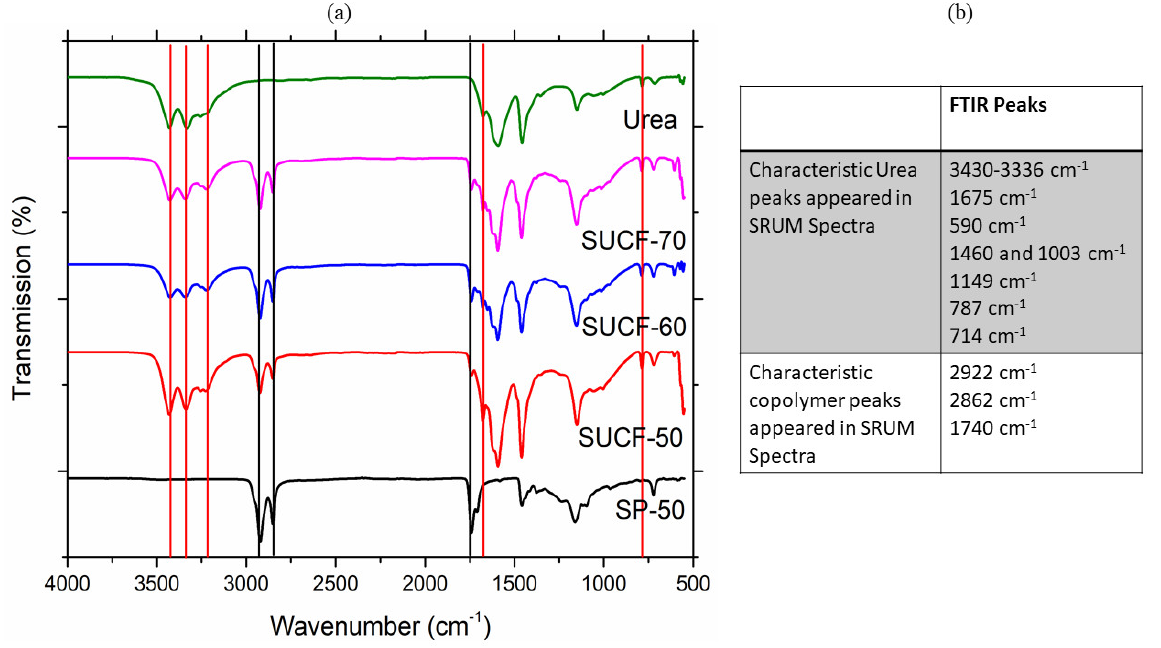
Figure 5. ( a ) FTIR-ATR of SUCFS and copolymer and ( b ) characteristic peaks of SUCFS. To investigate the morphological properties of the SUCFs, SEM images were taken and are depicted in Figure 6. The SEM images of the copolymers obtained at similar con- ditions depicted in Figure 4 show the smooth surface of the copolymer and isolated unre- acted S particles only, but the SEM micrographs of SUCFs shows smooth surface, isolated S particle, and appearance of new isolated particles with different morphology. By con- ducting the EDX mapping, we found that these new particles represent the urea added to the copolymer, thus confirming the addition of the urea to copolymer structure. The dis- tribution of the urea particle on the surface of the copolymer was found to be nonuniform; this can lead to the sudden release of the nutrient.